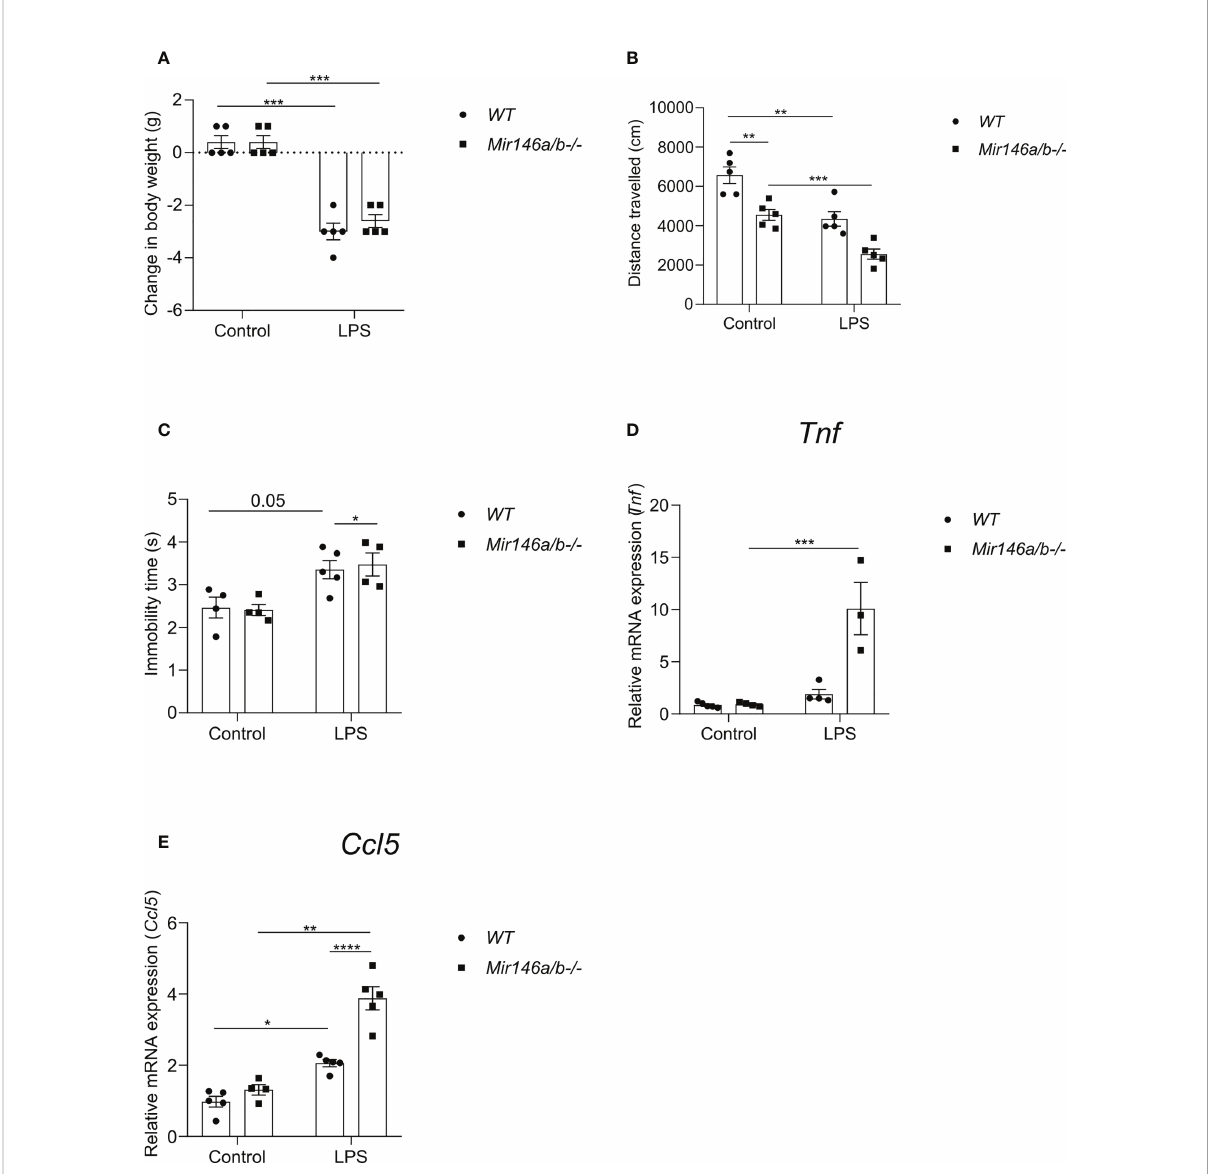
FIGURE 9 Effects of LPS on sickness behavior and proin fl ammatory cytokines in Mir146a/b-/- mice. (A) Change in body weight, (B) Locomotor activity and (C) Immobility time in tail suspension test was measured. (D) Relative expression of Tnf and (E) Ccl5 was analyzed by qPCR. Number of animals = 3-5. Data represented as mean ± SEM; * p < 0.05, ** p < 0.01, *** p < 0.001, **** p < 0.0001. (Welch ’ s ANOVA with Dunnett ’ s multiple comparisons